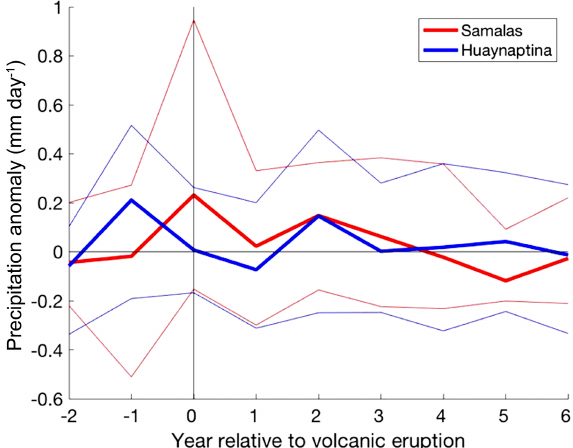
Figure 10. Mean NW Australian precipitation (mmday − 1 ) re- sponse of all volcanic ensembles (four CR ensembles and one 2 × G ensemble) to the largest (1258 Samalas) and smallest (1600 Huay- naputina) eruptions analysed over JASON. The bold lines represent the mean of all volcanic ensembles to each eruption, and the fainter lines represent the 90th and 10th percentile of the ensemble mem- bers.